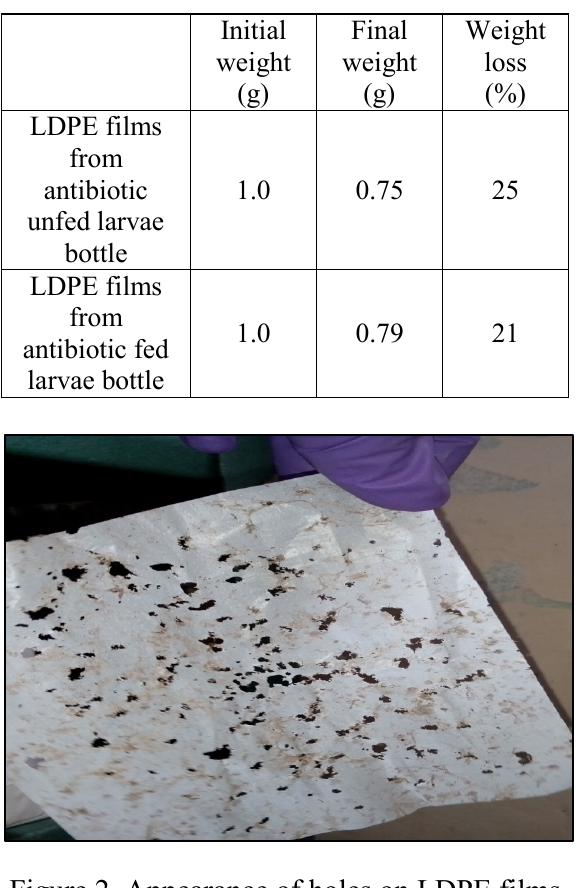
Figure 2. Appearance of holes on LDPE films